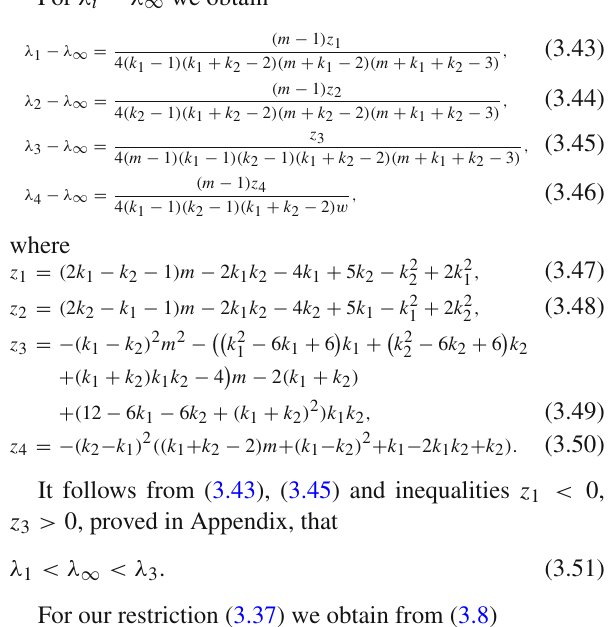
Fig. 1 The function λ = f ( x 1 ) for m = 4, k 1 = 6, k 2 = 7